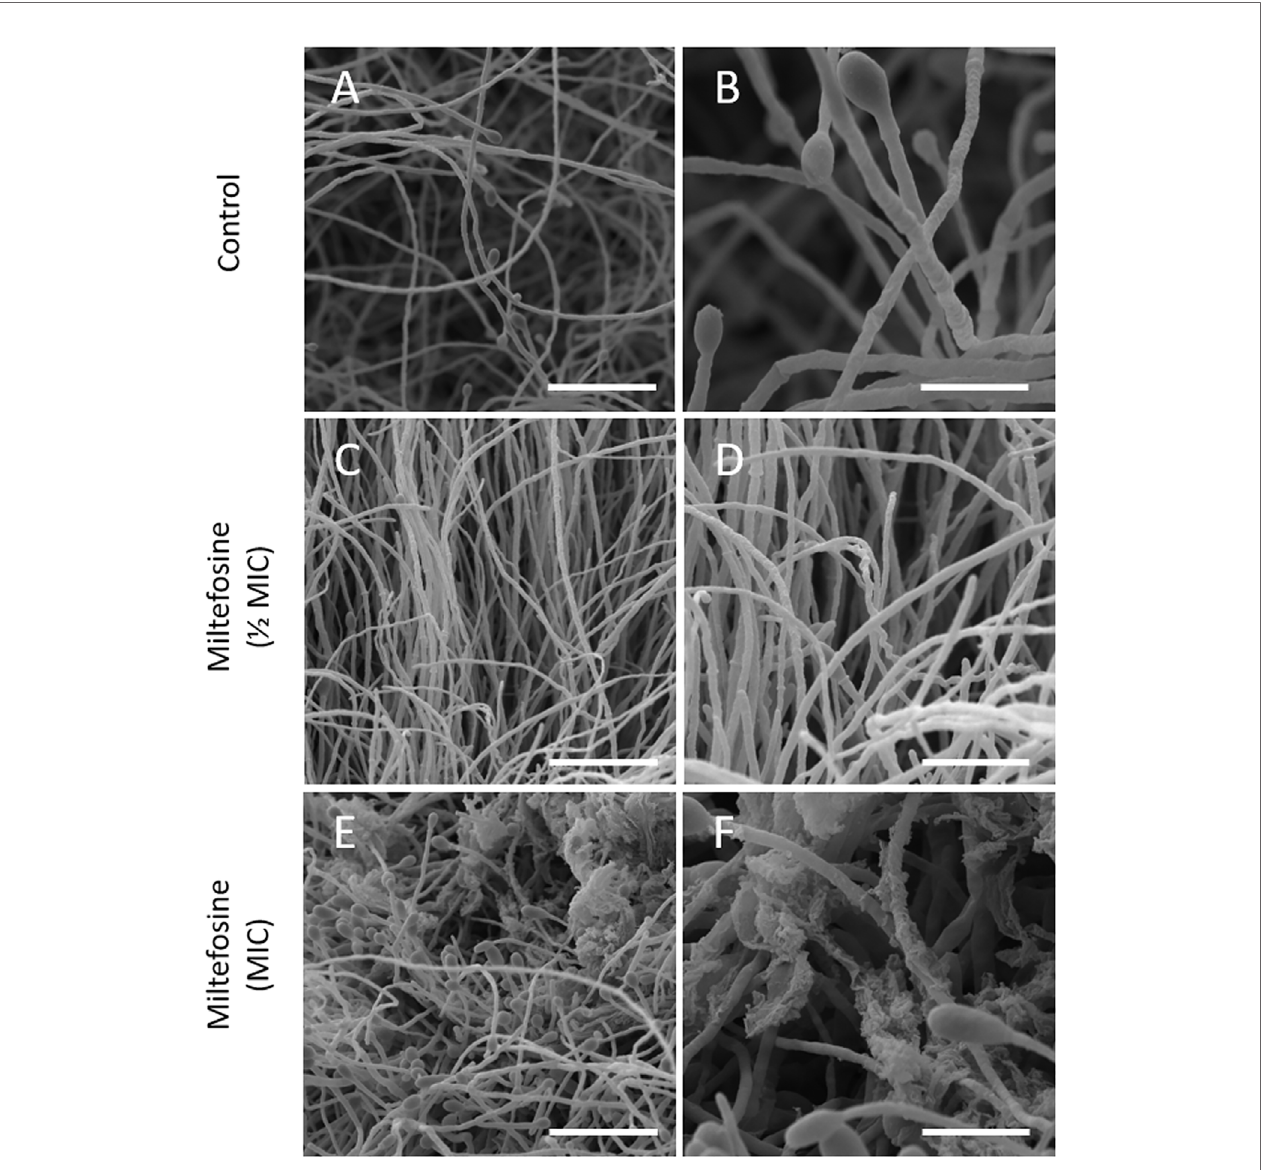
FIGURE 5 | Scanning electron microscopy of Scedosporium aurantiacum cells grown for 48 h in the presence of miltefosine. Scale bars: 20 m m (A, C, E) and 10 m m (B, D, F)